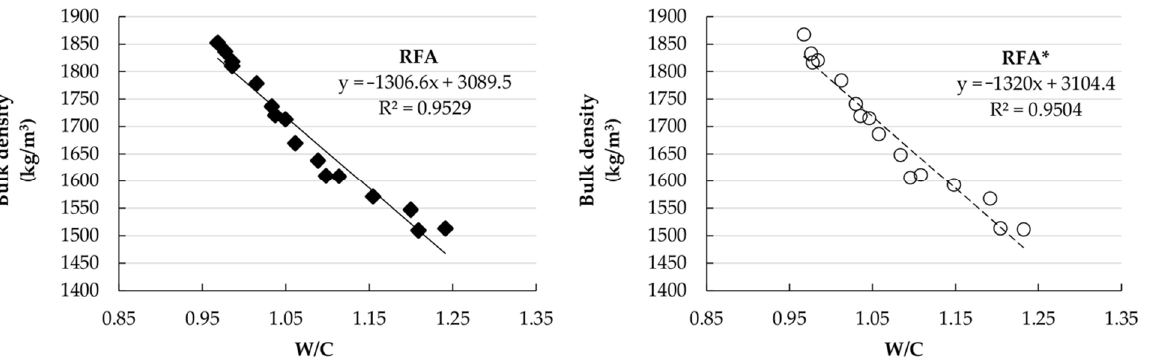
Figure 5. Correlation between the density of fresh mortar and the modifications in the water/cement (W/C) ratio for RFA and RFA*.